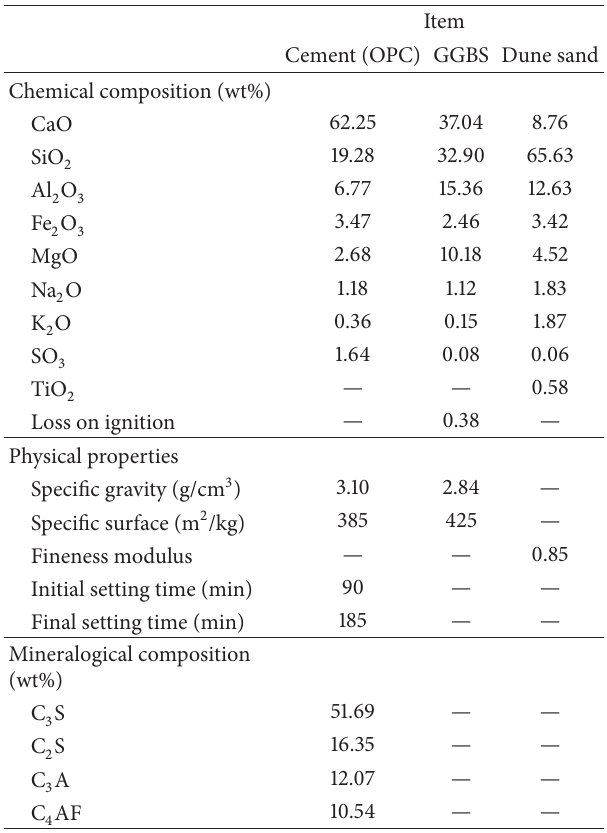
Table 1: Properties of OPC, GGBS, and dune sand.